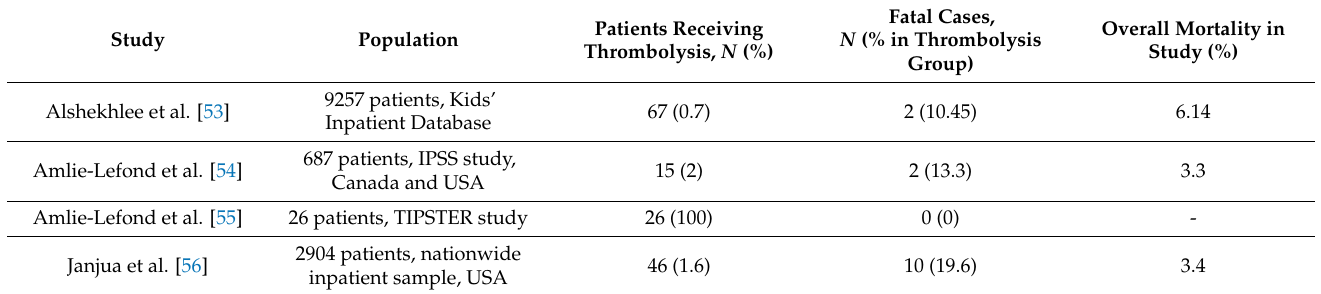
Table 4. Study on thrombolysis in pediatric patients: mortality rates.